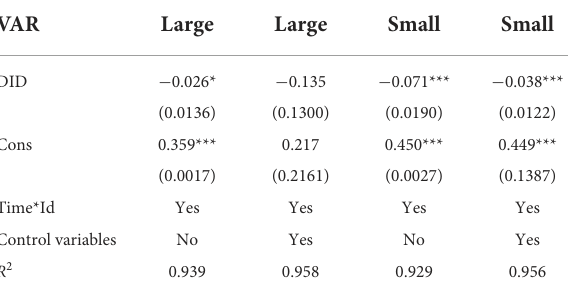
TABLE 8 Results of scale heterogeneity. TABLE 9 Results of moderation